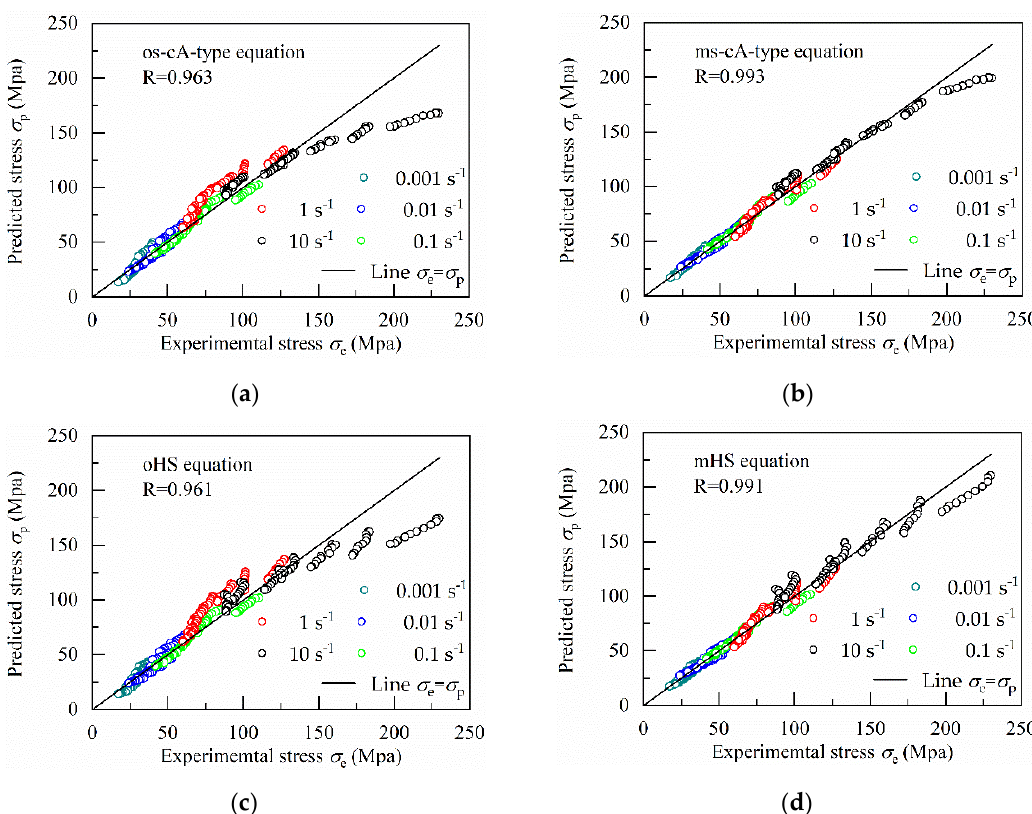
Figure 15. Correlation between the experimental stress and predicted flow stress values from ( a ) original strain-compensated Arrhenius-type (os–cA-type) equation; ( b ) modified strain-compensated Arrhenius-type (ms–cA-type) equation; ( c ) original Hensel–Spittel (oHS) equation; ( d ) modified Hensel–Spittel (mHS) equation.